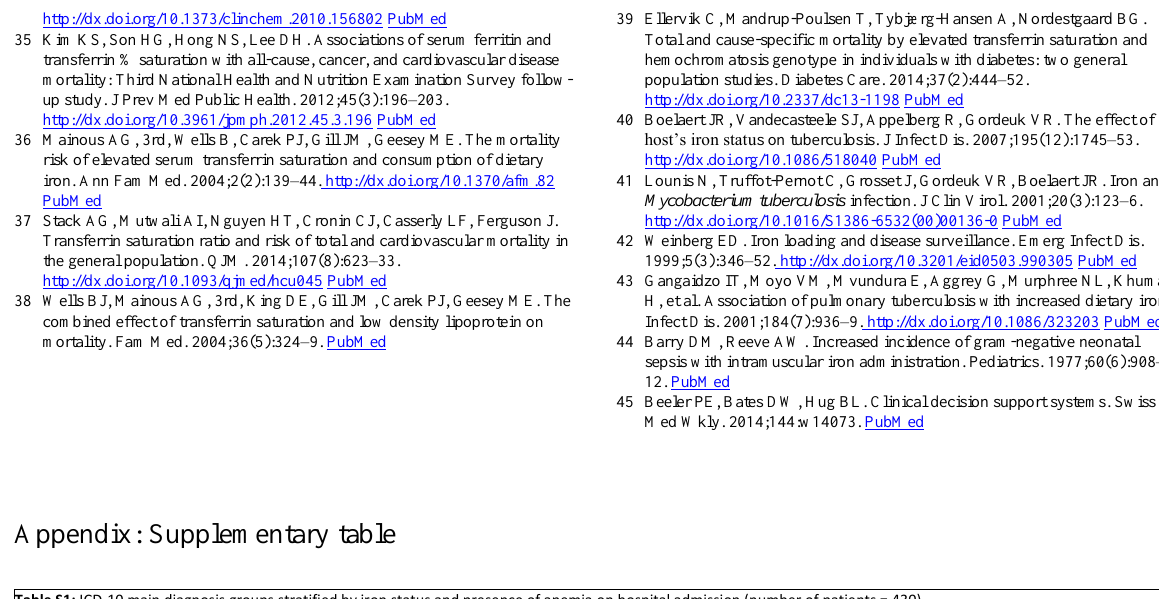
Table S1: ICD-10 main diagnosis groups stratified by iron status and presence of anemia on hospital admission (number of patients = 430). Iron status /